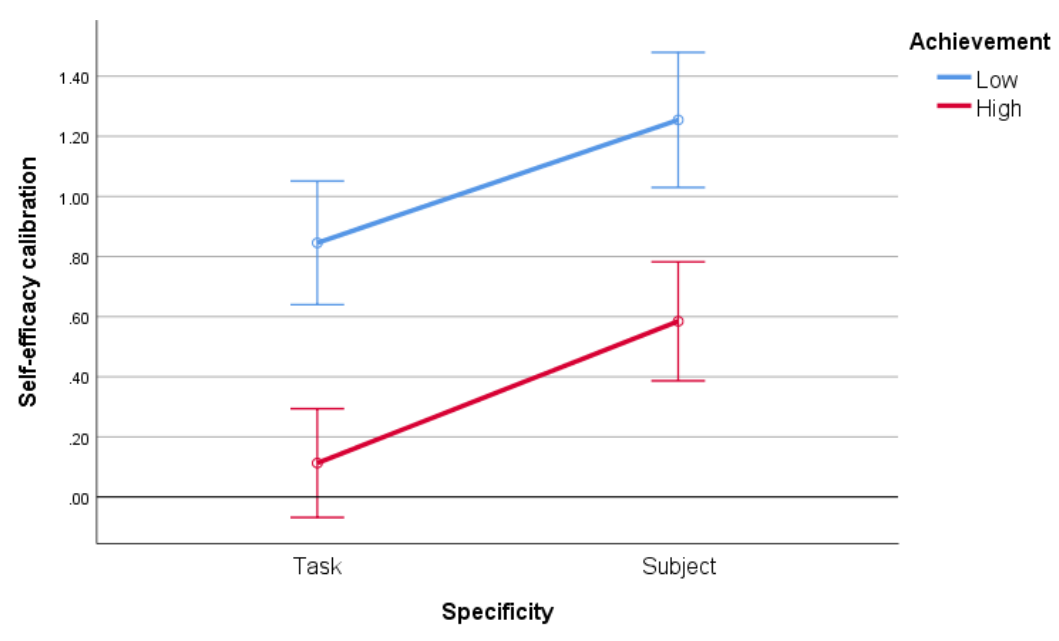
Self-efficacy Bias by Specificity and Achievement Level